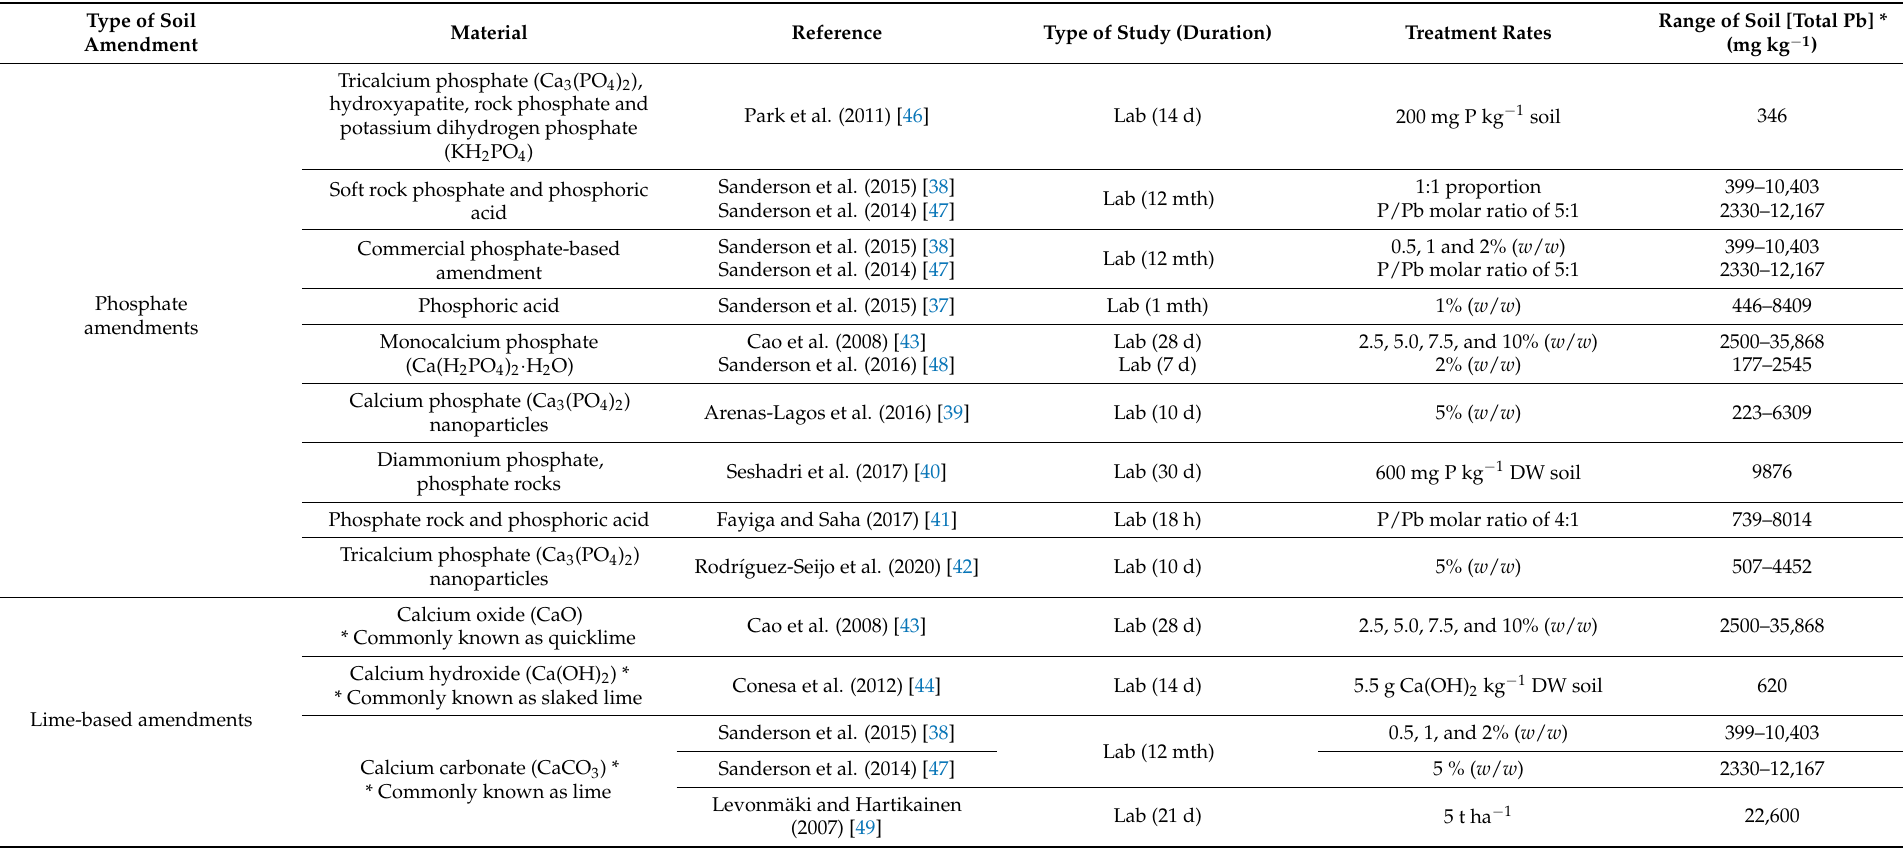
Table 1. Inorganic materials used as amendments for Pb immobilization in shooting range